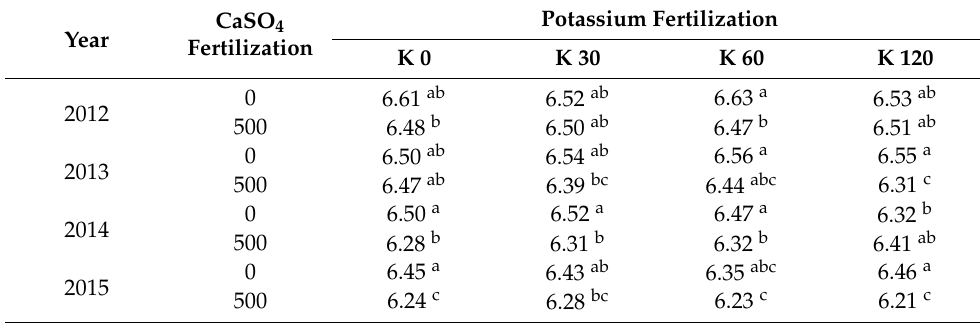
Table 4. Effect of analyzed factors on pH of soil.